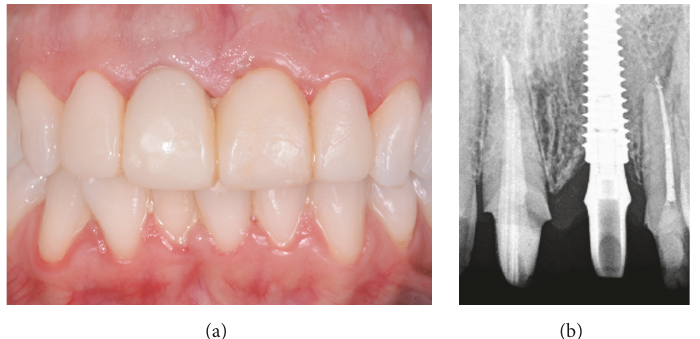
Figure 6: The provisional restoration after 2 months. The soft tissues outline has been modeled by the temporary and the level and curvature of the facial mucosa look better, even if oral hygiene should be improved. (a) Clinical view; (b) radiographic